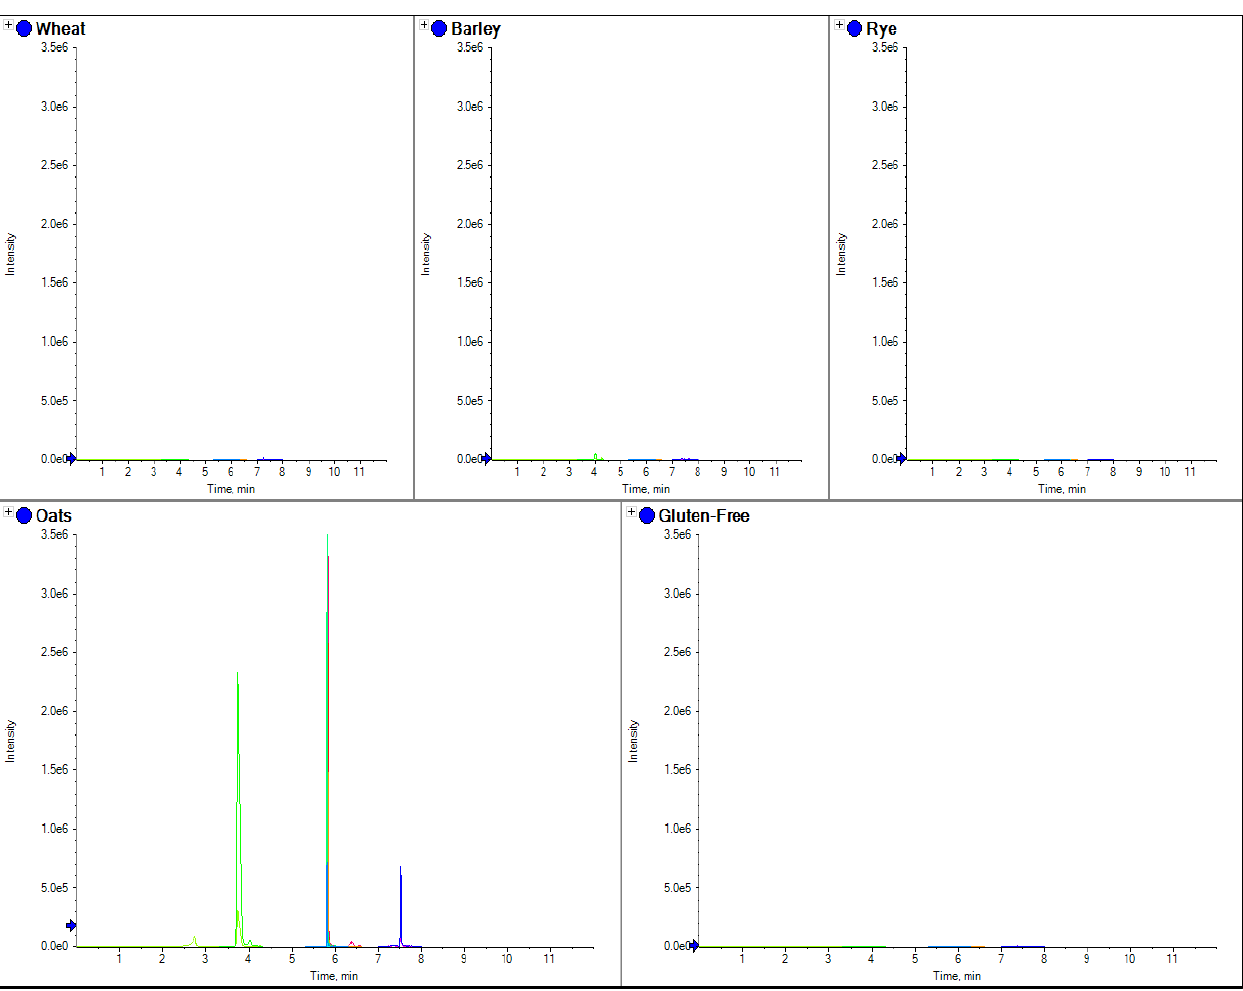
Figure 3. The comparison of separate extracts from barley, wheat, rye, oats and gluten free flour. Here the overlaid chromatograms for oats marker peptides (obtained from the theoretical digestion of avenin) have been shown for flour extract for each